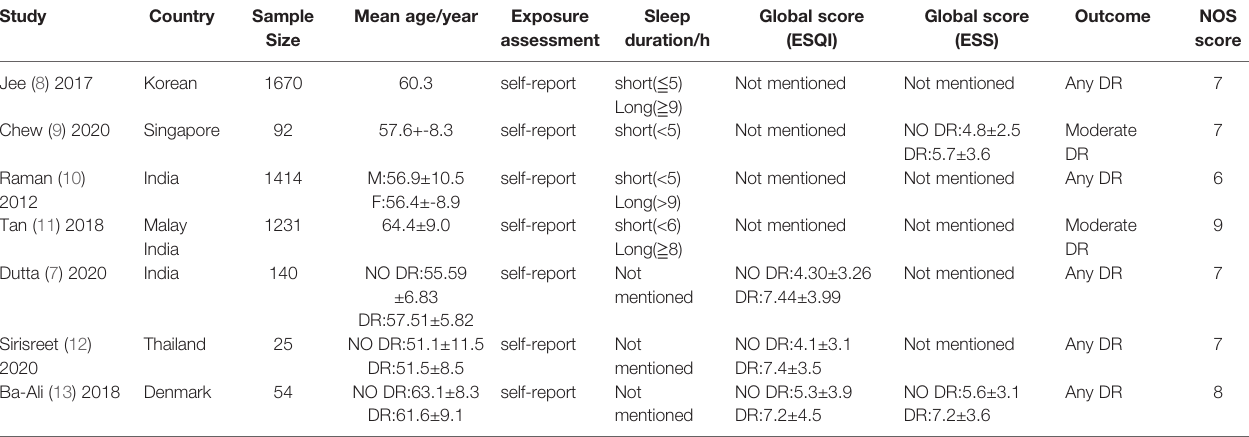
TABLE 1 | Characteristics of the included